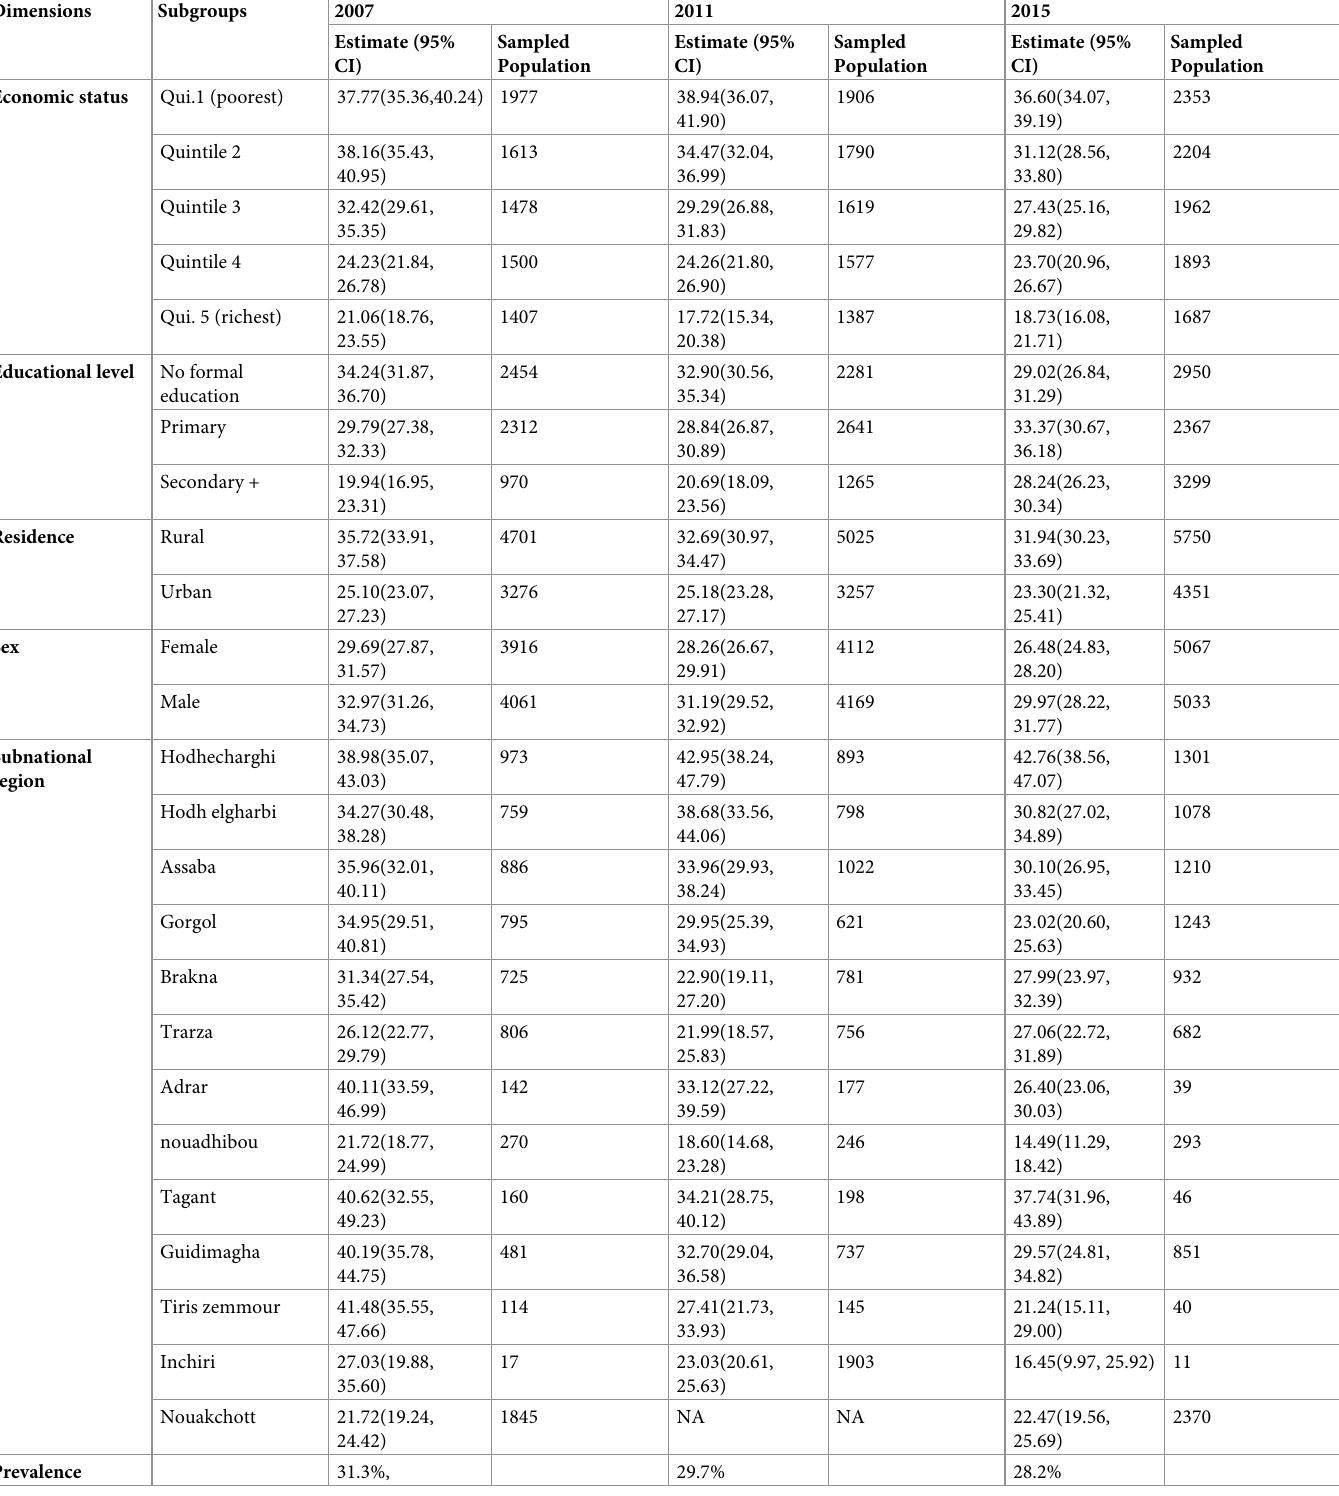
Table 1. Over time trends of the childhood stunting disaggregated by the different sub-populations in Mauritania, 2007–2015.